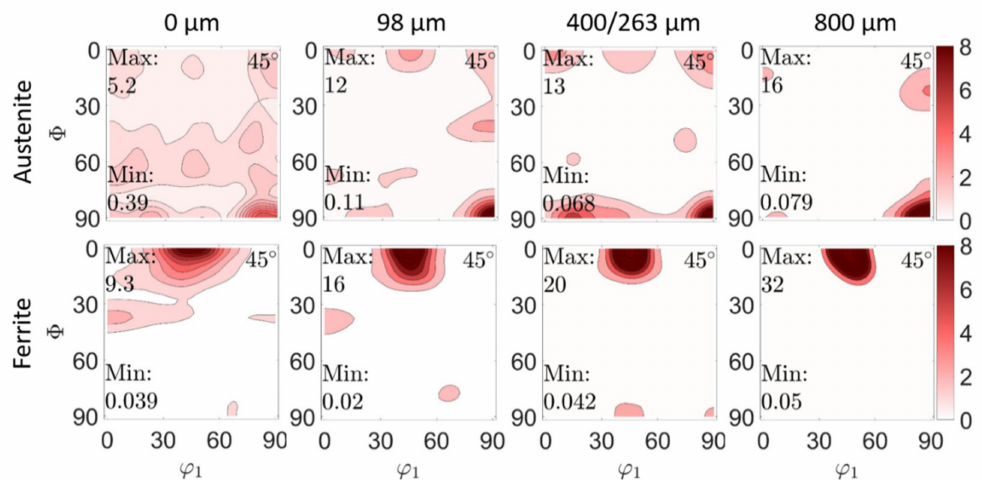
Figure 8. Crystallographic texture of the austenite and ferrite phases for the duplex stainless steel 1.4460, and evolution of the phase-specific texture in depth for the work hardened state (after deep rolling). The presented selected depths correspond with different degrees of work hardening. The initial texture is displayed in Figure